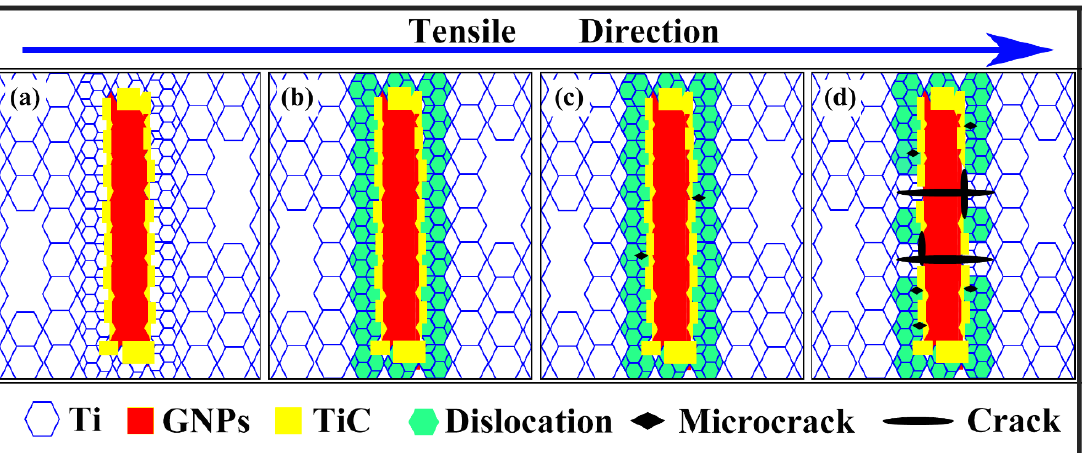
Figure 4. The schematic images of fracture process: ( a ) as-extruded composites, ( b ) yield stage, ( c ) minor plastic deformation stage, ( d ) major plastic deformation stage.